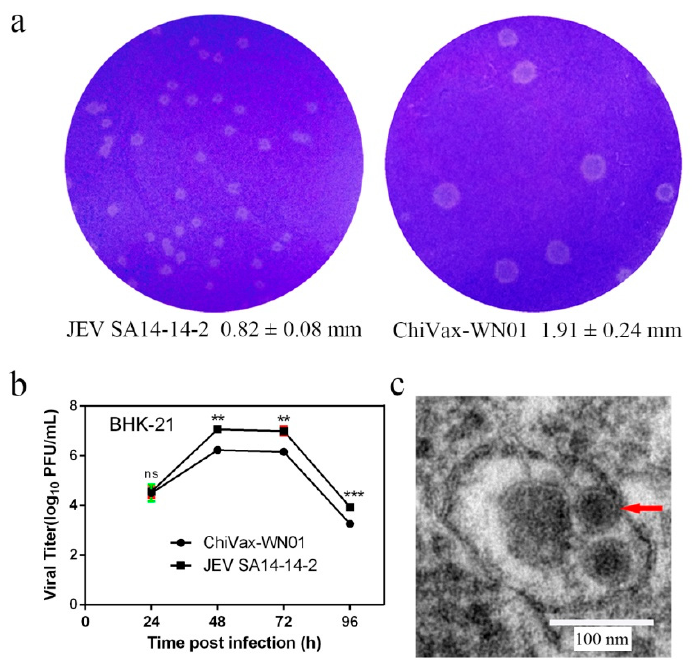
Figure 3. Characteristics of ChiVax-WN01. ( a ) Plaque morphology and size of JEV SA14-14-2 and ChiVax-WN01 in BHK-21 cells at 5 days post inoculation (d.p.i.). ( b ) Growth curves of JEV SA14-14-2 and ChiVax-WN01 in BHK-21 cells. Data are shown as the means ± SDs and were analyzed by student’s t -test (** p < 0.01, *** p < 0.001). ( c ) Morphology of ChiVax-WN01 (red arrow) by the trans- mission electron microscope.